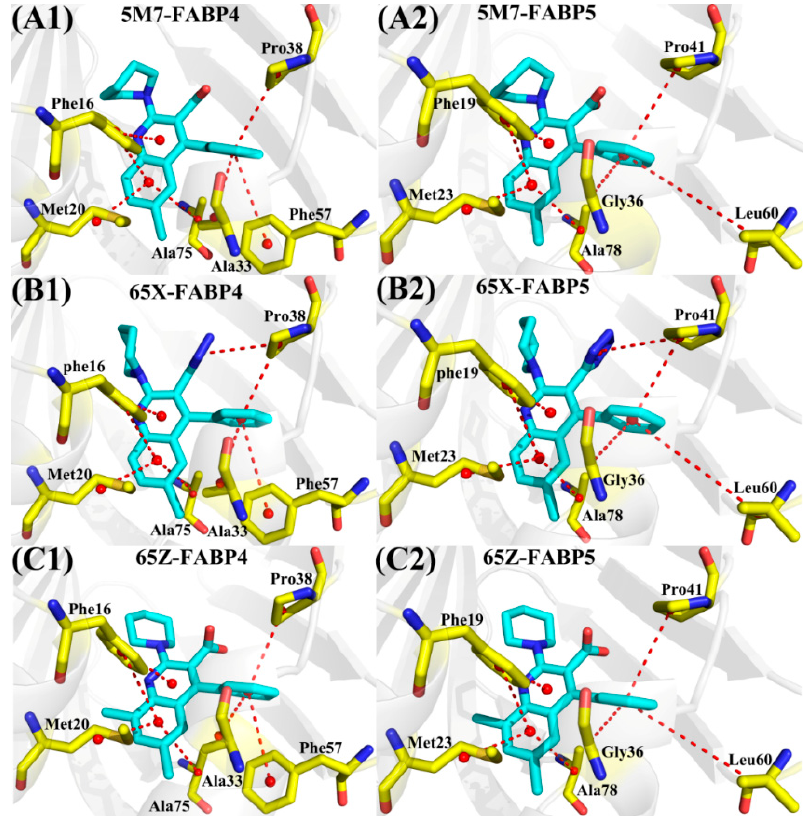
Figure 5. Geometric positions of inhibitors relative to the key residues involving significant interactions, the averaged distances between atoms involving significant interactions were calculated and displayed in the red lines. ( A1 / A2 ) 5M7-FABP4/FABP5; ( B1 / B2 ) 65X-FABP4/FABP5; and ( C1 / C2 ) 65Z-FABP4/FABP5. All inhibitors and key residues in inhibitor-FABP4/5 complexes are separately shown in light blue and yellow.